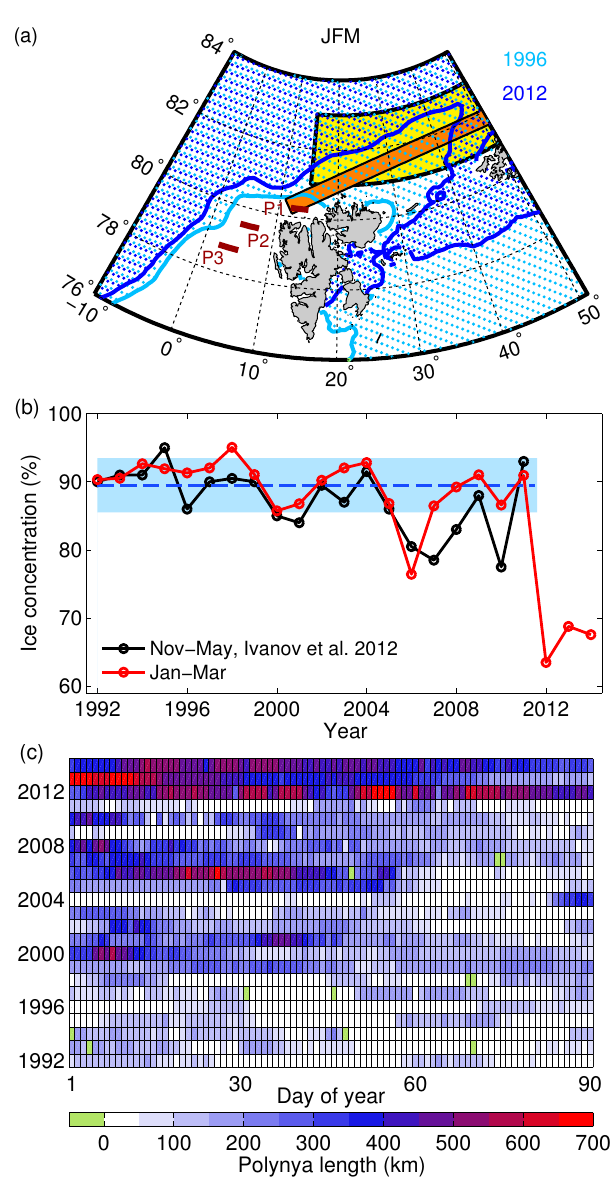
Figure 1. Mean JFM ice edge (based on 70% SSM/I-ASI ice con- centration) in 1996 (light blue) and 2012 (dark blue), and areas used for calculation of the mean ice concentration in the Western Nansen Basin (WNB, yellow) and the length of the Whaler’s Bay polynya (orange) (a) . The three positions (P1–P3) used for the temperature analysis are marked in dark red. Time series of the winter mean sea ice concentration in the WNB (red) with the 20-year mean and one standard deviation (blue) (b) . Data from Ivanov et al. (2012) are shown for comparison (black). Polynya length for the years 1992 to 2014 as a function of day of the year (c) . Green color denotes missing